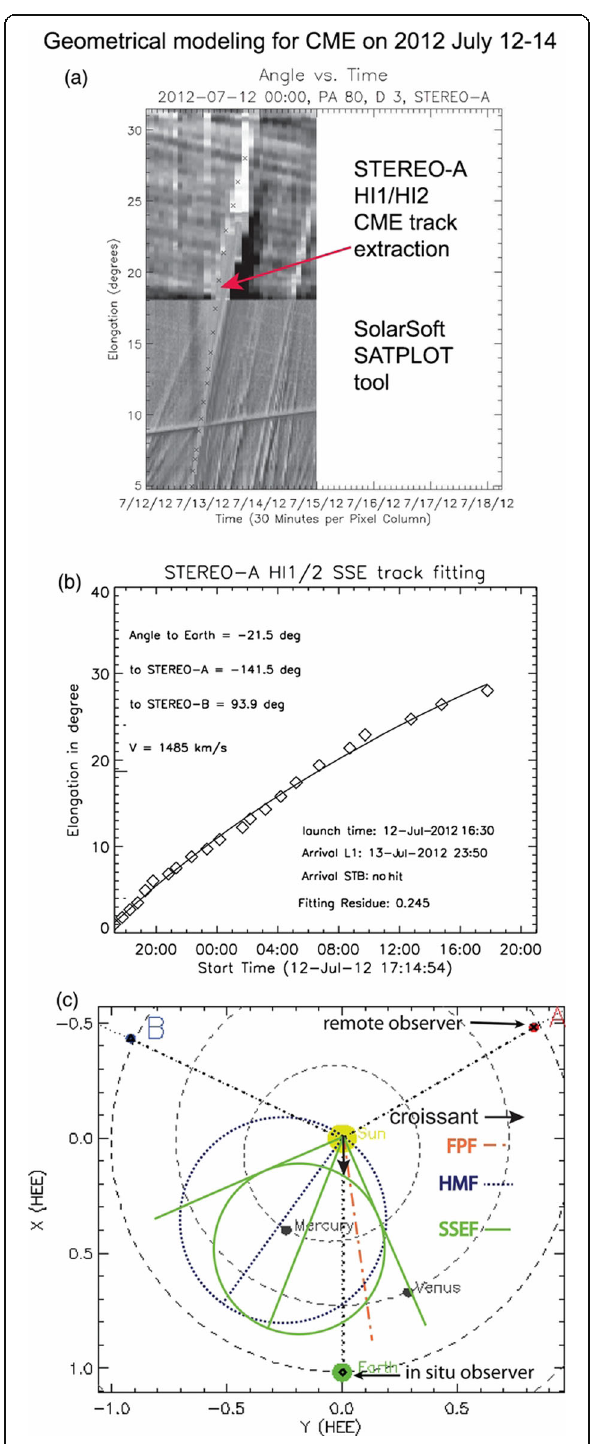
Fig. 3 An example of measuring CME (July 12 – 14, 2012 CME) leading fronts using slice-stacking plot or J-map and geometric models. a The density track of the CME viable in a J-map from STER EO-A. b Fits of the extracted CME track with the SSEF (Self-Similar Expansion Fitting) model. c The resulting geometry of the event, with propagation directions derived from FP (dot-dashed red line, 0° full width), SSEF (solid green line, 90° full width), and HM (dotted blue line, 180° full width) geometric assumption of the CME. Adopted from Möstl et al.